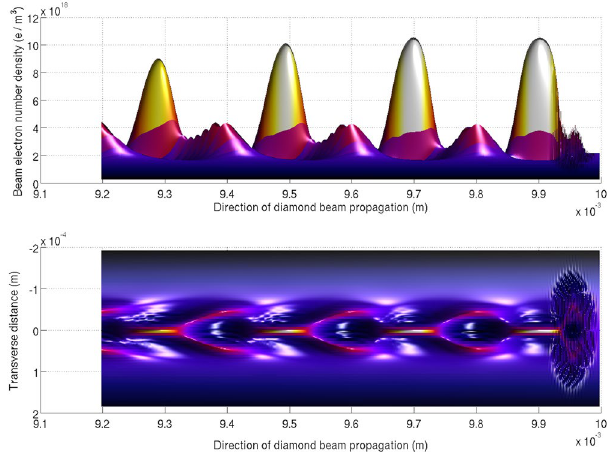
Figure 2. The micro-bunched Diamond beam. Between the yellow micro-bunches are the beam electrons that propagated with the de-focusing regions of the wakefield and are in the process of being transversely expelled. The disturbance to the beam in the right of the panes is due to the laser